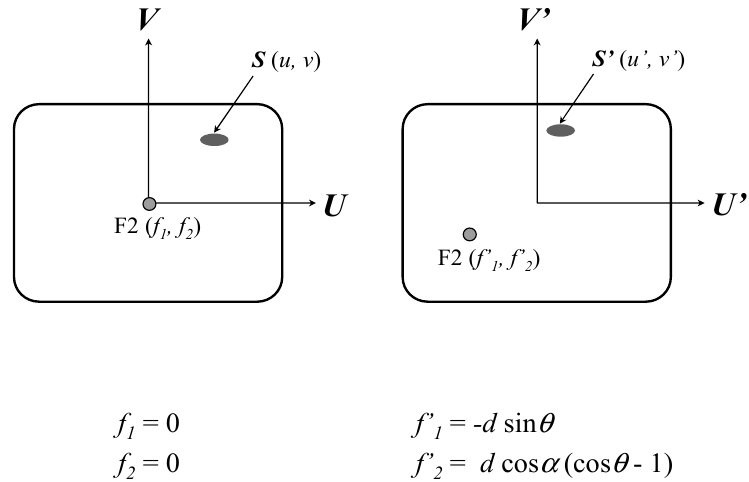
Figure 3. The schematic diagrams of the fluorescent images. On the left, the C-arm is upright; and, on the right, the C-arm rolls at an angle θ